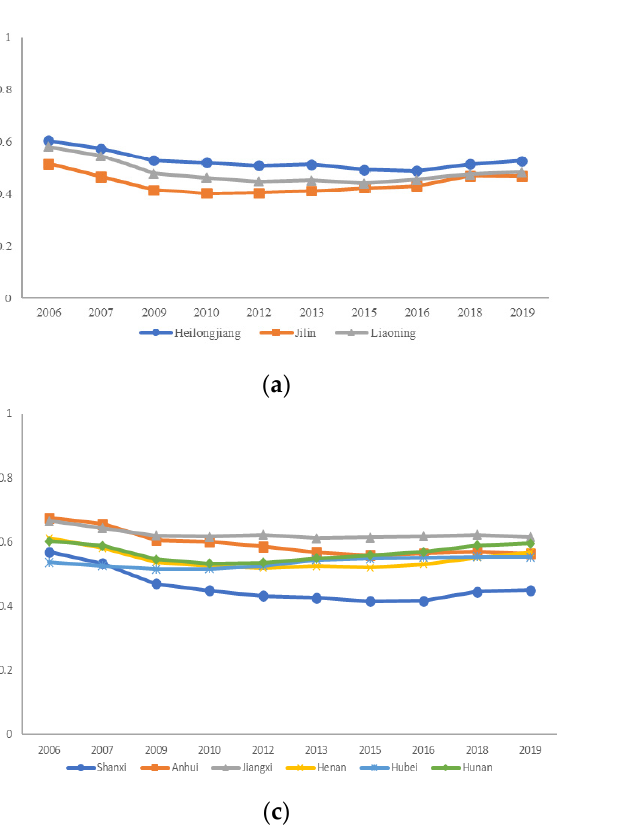
Figure 2. ( a ) Initial results of carbon emission efficiency in Northeastern China, 2006–2019; ( b ) initial results of carbon emission efficiency in Eastern China, 2006–2019; ( c ) initial results of carbon emission efficiency in Central China, 2006–2019; ( d ) initial results of carbon emission efficiency in Western China, 2006–2019. Note: To ensure the effect of the figure, the results of 2008, 2011, 2014, 2017 are not shown; please contact the author to obtain them if necessary.